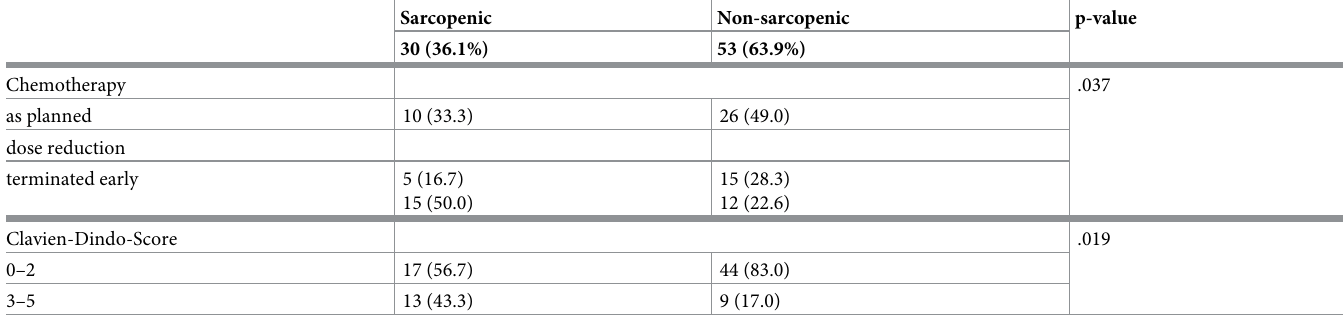
Table 2. Perioperative complications in sarcopenic vs. non-sarcopenic